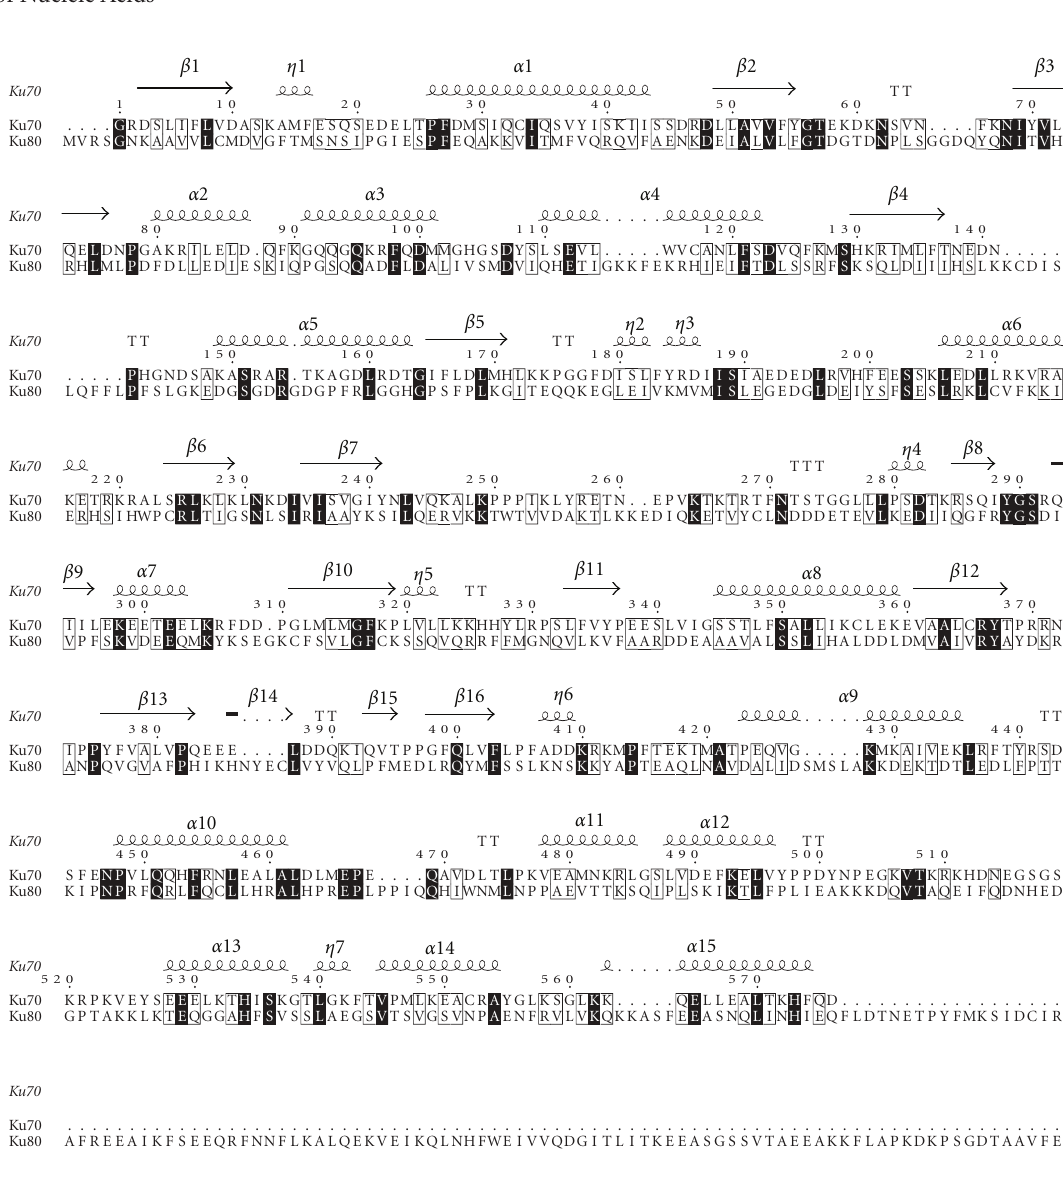
Figure 2: Ku70 and Ku80 aligned sequences on the basis of their structures. They show a similar domain organisation despite the low sequence identity. The alignment was created with ClustalW2 [41] and visualized with ESPript [42]. Many residues are conserved ( black box ) or semiconserved/similar ( gray box